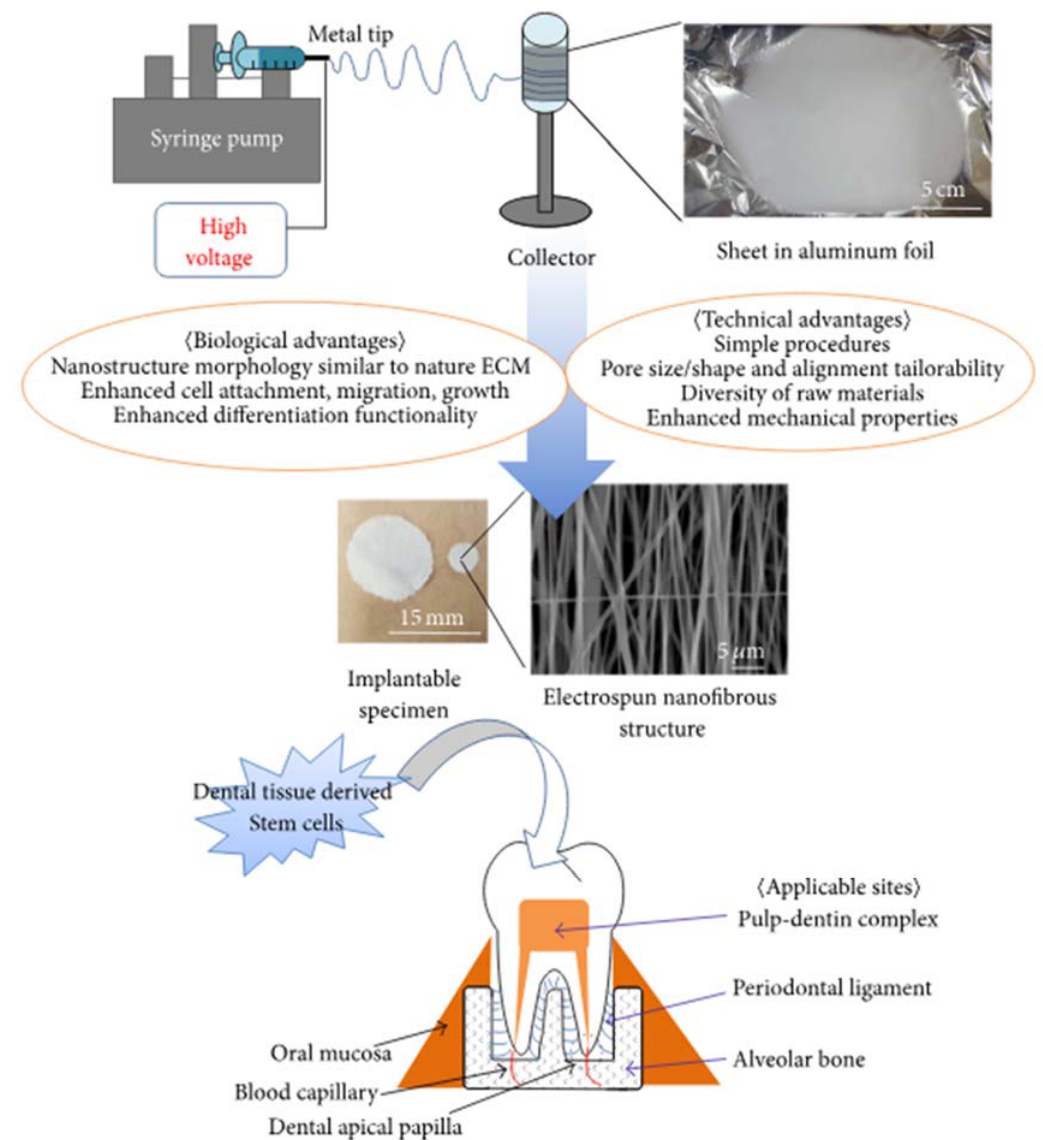
Figure 6. Dental tissue regeneration using polycaprolactone (PCL) electrospun nanofibrous scaffold biomaterials. Adapted from Seo et al. [216] .